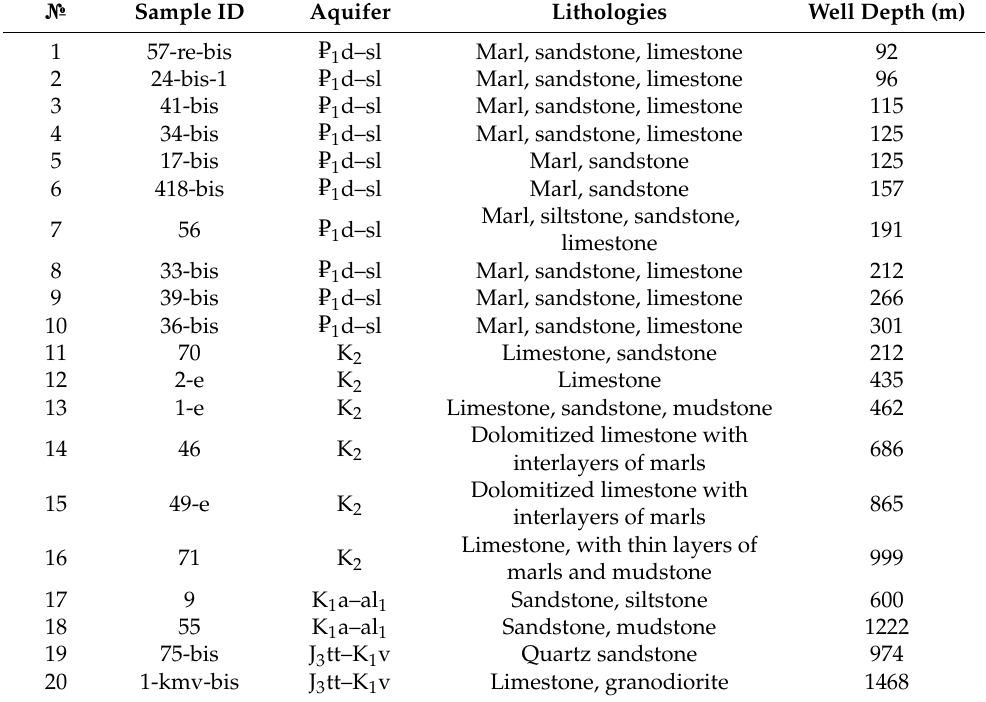
Table 1. Characteristics of the studied water